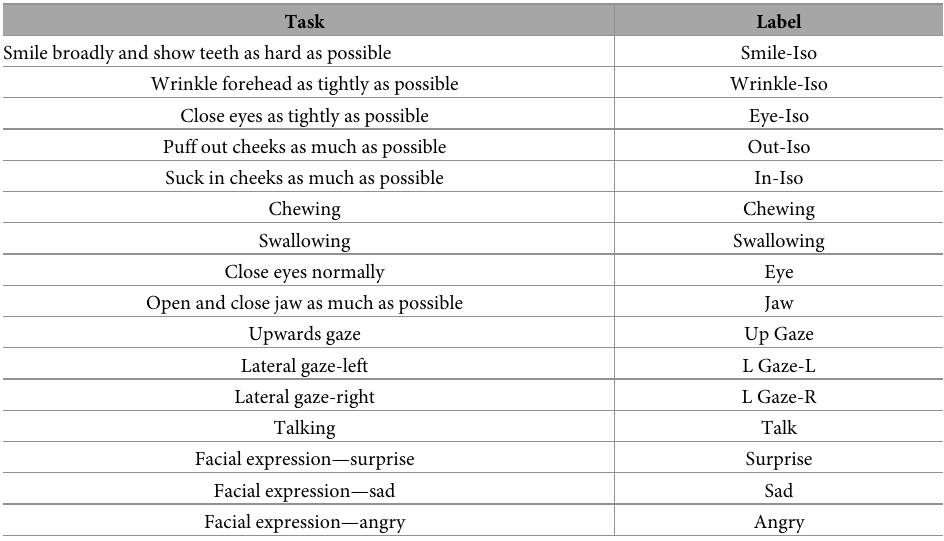
Table 4. Task label